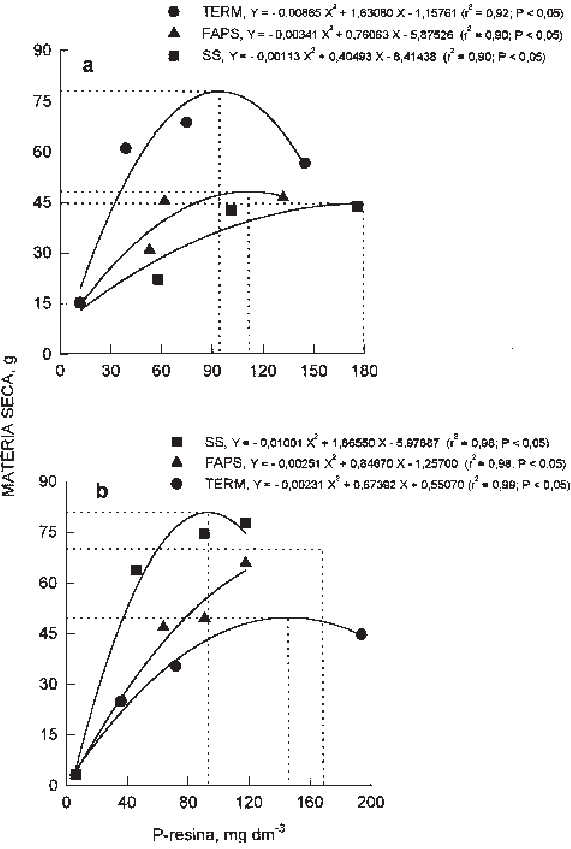
Figura 1. Crescimento das mudas de eucalipto aos 90 dias pós-emergência em função das concentra- ções de P recuperadas pela resina. As linhas descontínuas destacam os níveis críticos de P, para as diferentes fontes de P e solos ( a ) areia quartzosa e ( b ) latossolo vermelho-escuro, res- ponsáveis pelas produções máximas de matéria seca da parte aérea. O AQ recebeu 0, 75, 150